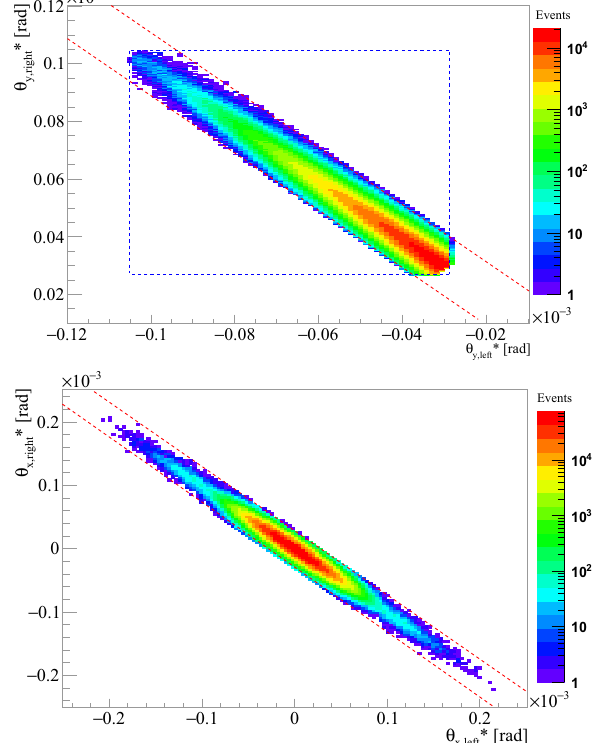
Fig. 2 The collinearity of the vertical and horizontal scattering angles. Thebluelinesrepresenttheangularacceptancecutsintheverticalplane around the acceptance edges. The red ones show the 4 σ physics cuts